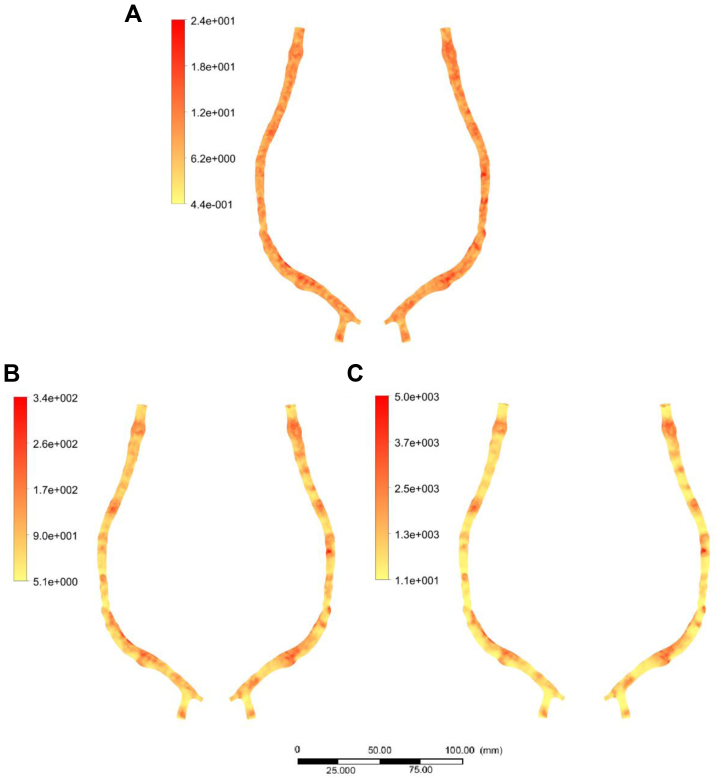
Predicted evolution of smooth muscle cells per baseline value (363 cells/mm2) in the intimal layer of the bypass at different time points during the neointimal hyperplasia (NIH) phase (patient 3, non-newtonian case using the highly oscillatory, low magnitude shear [HOLMES] index). A, Snapshot at 146 days after intervention. B, Snapshot at 438 days after intervention. C, Snapshot at 730 days after intervention.